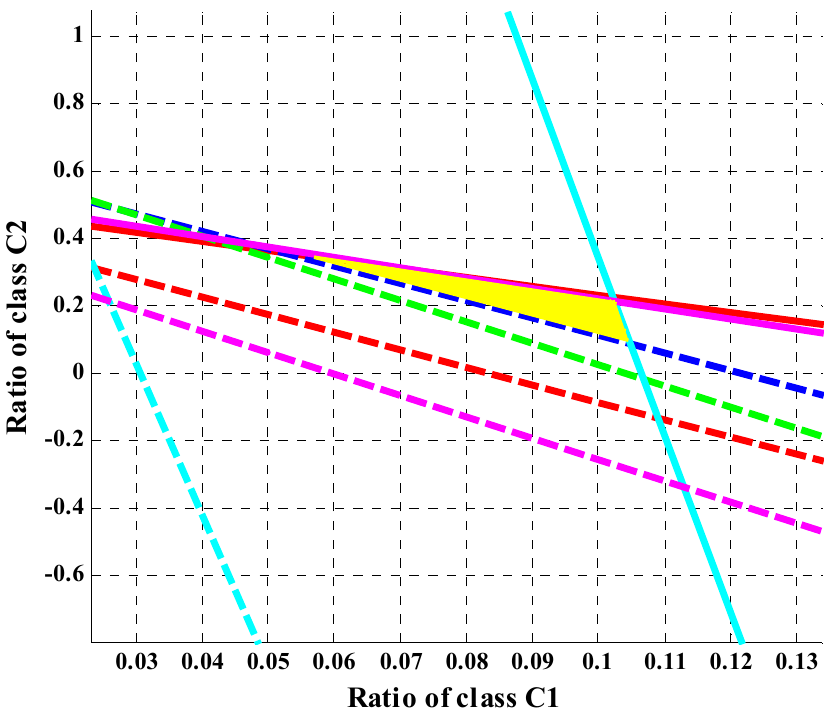
Figure 5. Lines where surfaces of experimental trunk stiffness intersect with those of maximum and minimum stiffnesses, for the five directions of displacement perturbation, with β 3 set to 0.15. The yellow area represents the feasible solutions β 1 and β 2 for the given value of β 3